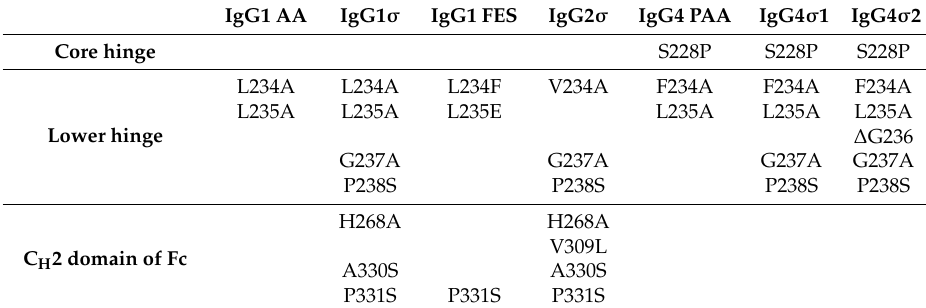
Figure 2. Schematic indicating positions of mutations on generic Fc structure. Positions mutated relative to parental subtype are depicted as red spheres on a structure of IgG1 Fc having an idealized hinge (wheat and blue, cartoon) for IgG1 σ ( A ), IgG2 σ ( B ), and IgG4 σ 1/2 ( C ). For clarity, the sites of mutation are labeled on only one of two equivalent Fc chains. IgG4 σ 2 differs from IgG4 σ 1 by the deletion of G236 (position indicated with a small, grey sphere and labeled with an asterisk). Table 1. List of mutations in the hinge and constant heavy chain domain 2 (C H 2) regions of different silent immunoglobulin (IgG) designs.